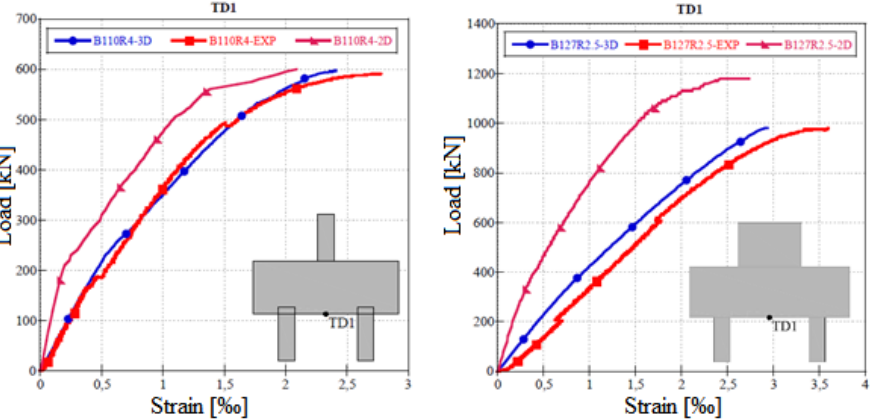
Figure 10. Load versus displacement curves of the models of series B110R4 and